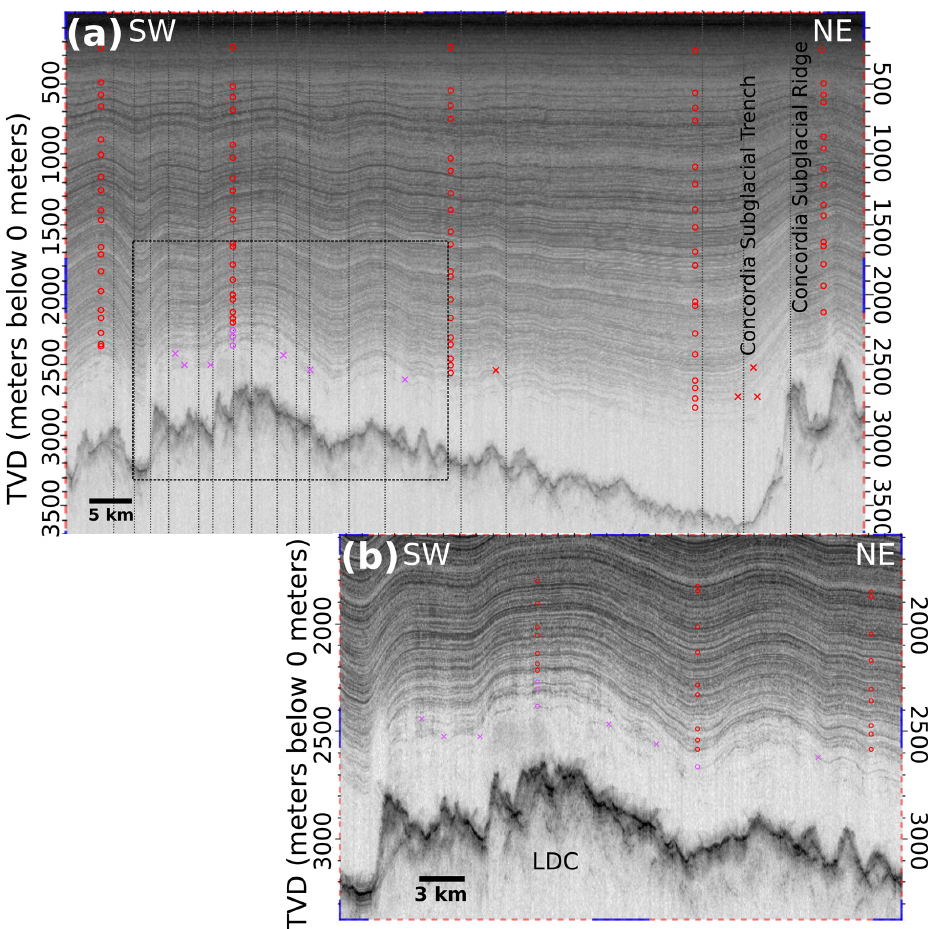
Figure 3. Radargram showing the depth distribution of the IRHs. (a) The full transect displayed here (OIA/JKB2n/X57a) starts over the LDC and crosses over the Concordia Subglacial Trench and Ridge, where the deepest IRHs cannot be traced across (transect is indicated in Fig. 1). Red and magenta circles highlight the dated and undated IRHs, respectively (see Sect. 3.4.2 for definitions), and red and magenta crosses indicate where each IRH tracing is interrupted. Crossing transects are indicated by dashed vertical black lines. (b) Detailed view of the bottom half of the ice column over LDC, where the undated IRHs are most densely traced, although they end quite quickly with distance from the LDC bedrock